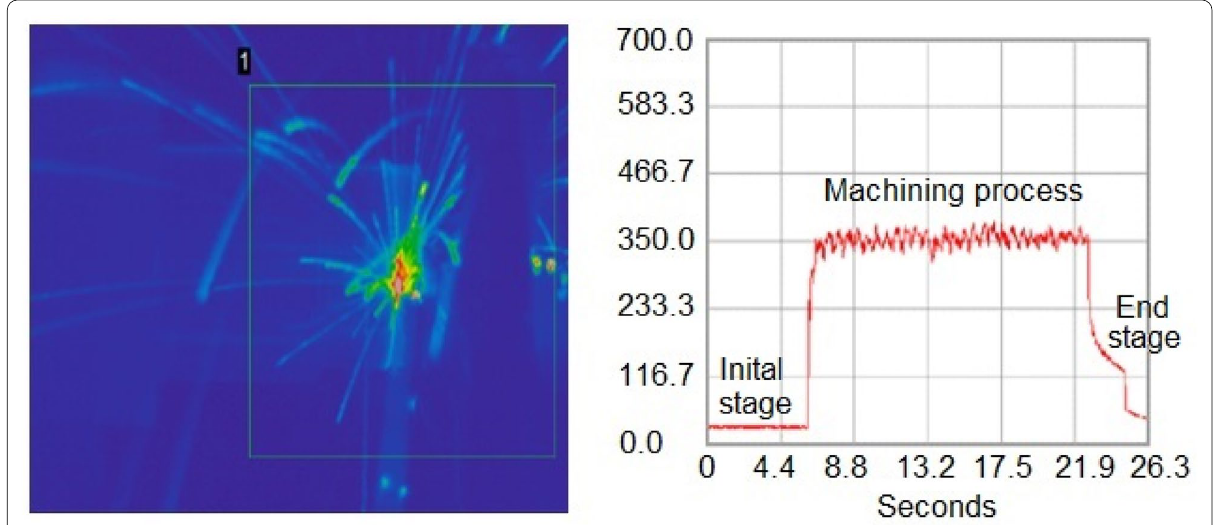
Figure 5 Thermal image obtained while measuring the cutting temperature with a thermal infrared